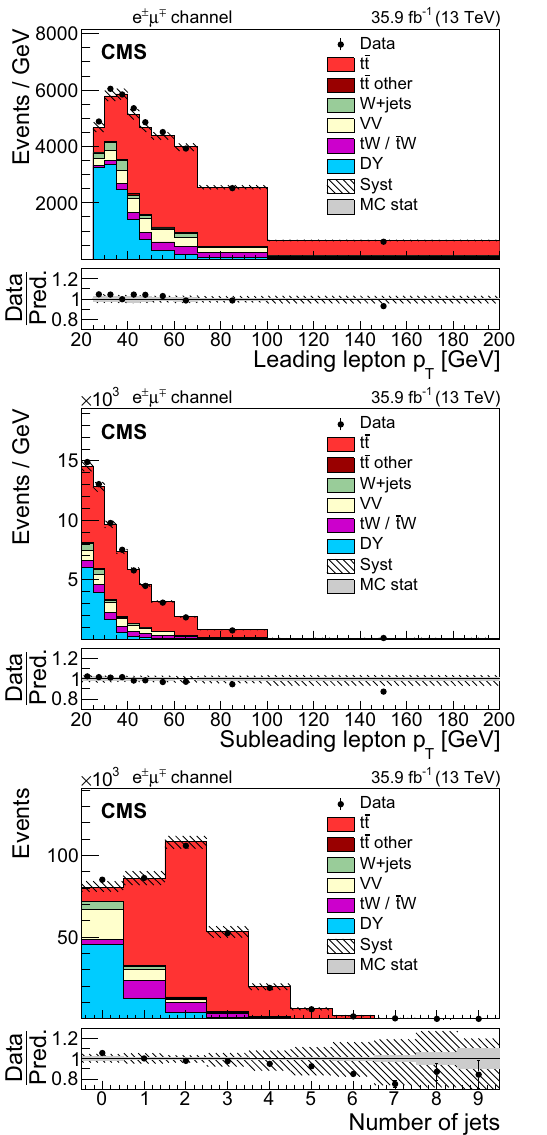
Fig. 1 Distributions of the transverse momentum (left) and pseudo- rapidity (right) of the leading (upper) and subleading (middle) leptons in the e ± μ ∓ channel after the event selection for the data (points) and the predictions for the signal and various backgrounds from the sim- ulation (shaded histograms). The lower row shows the jet (left) and b-tagged jet (right) multiplicity distributions. The vertical bars on the points represent the statistical uncertainties in the data. The hatched